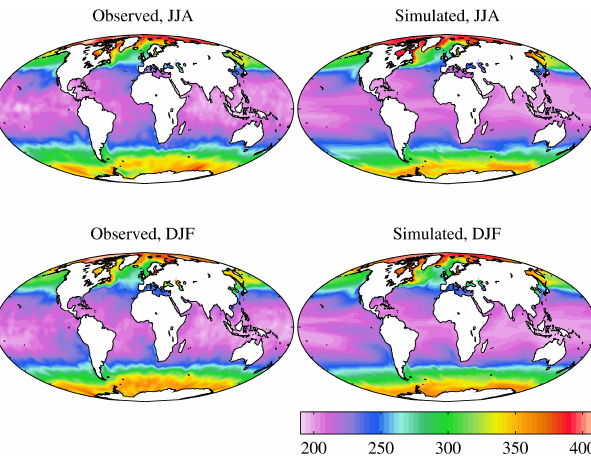
Fig. 25. Observational (World Ocean Atlas, 2009; left) and simulated (right) surface dissolved oxygen for northern summer (June-July-August; top) and northern winter (December-January-February; bottom). Concen- trations in mmol O 2 m − 3 . Fig. 22. Hovm¨oller diagrams of observational (Takahashi et al., 2009; left) and simulated (right) monthly air–sea CO 2 flux, averaged zonally for the Atlantic (top) and Pacific (bottom) basins. Air–sea CO 2 flux in mol C m − 2 month − 1 .